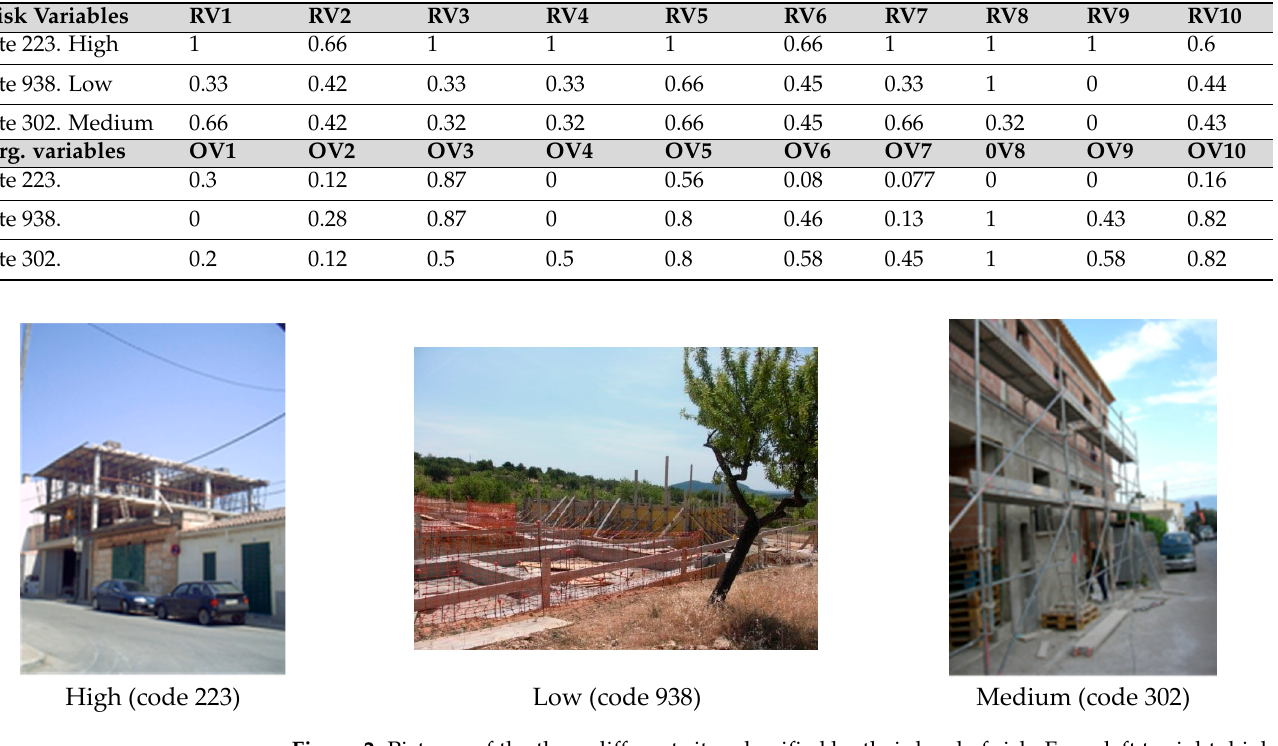
Figure 2. Pictures of the three different sites classified by their level of risk. From left to right: high (code 223), low (code 938), and medium (code 302). Source: from the authors’ archive.